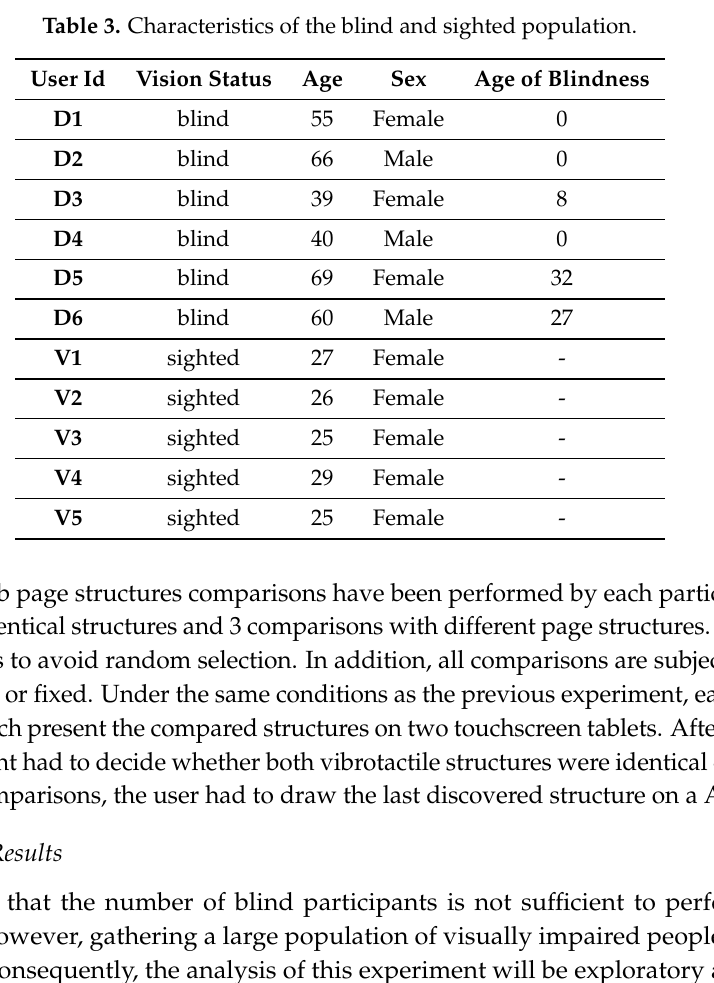
protocol. Figure 9 gathers results for all the comparisons of all pairs of vibrotactile pages,